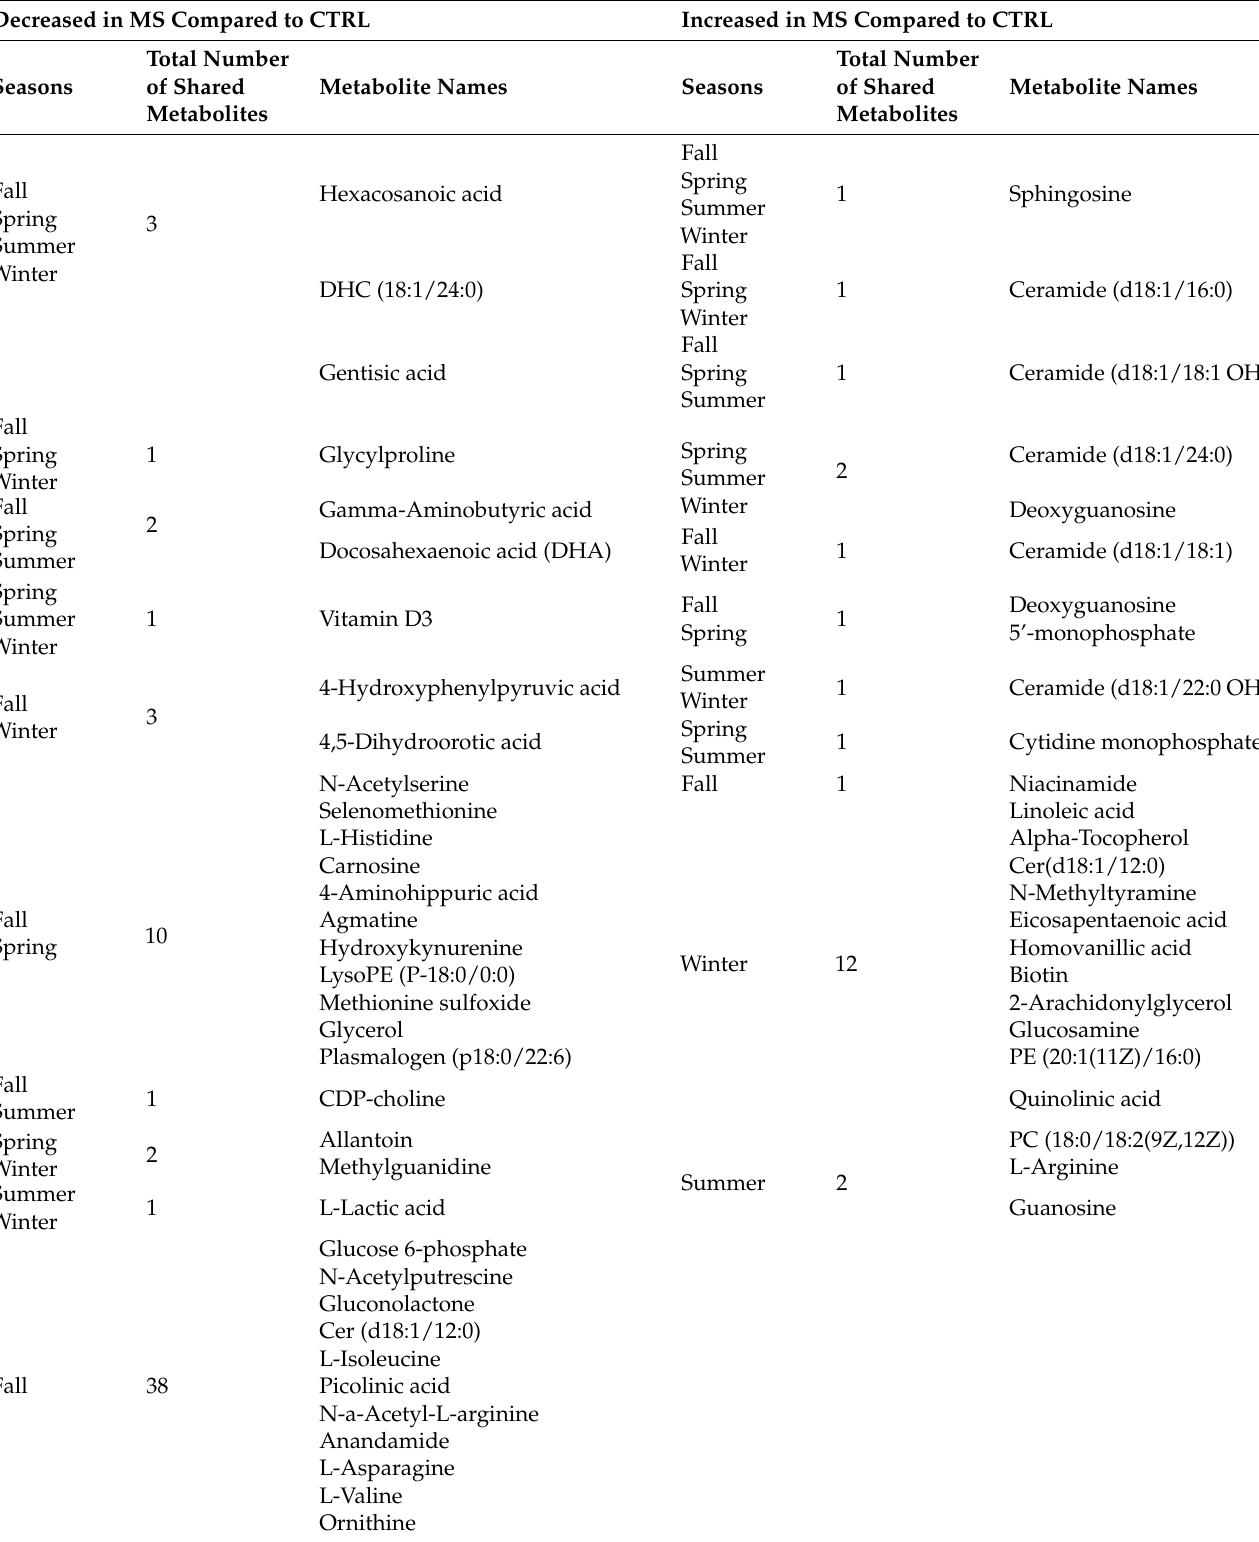
Table 1. List of metabolites significantly changed in MS group in comparison to